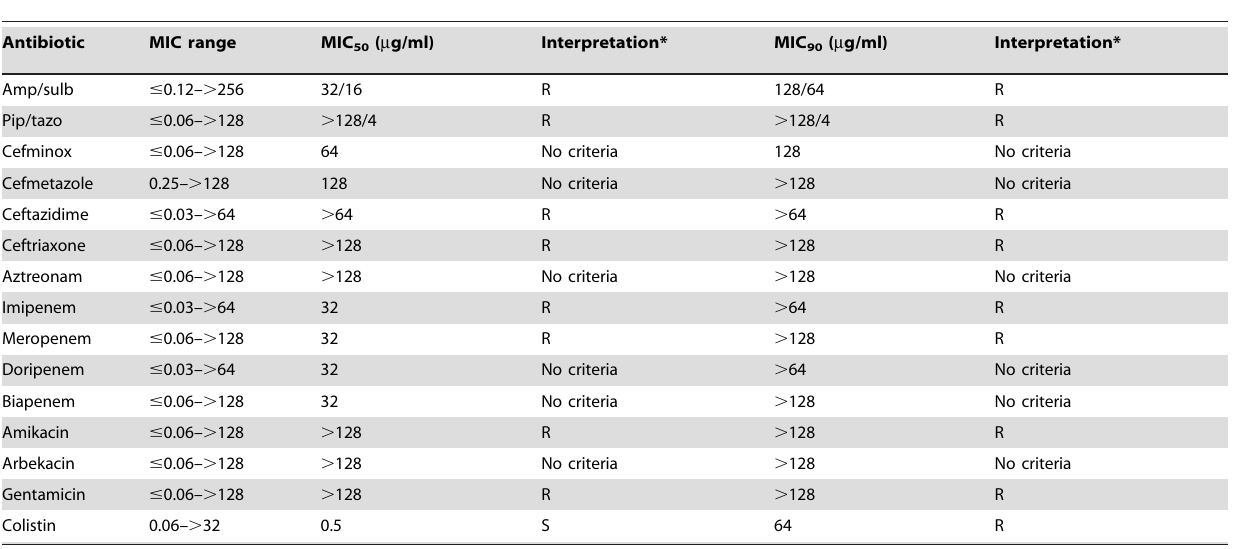
Table 5. Determination and interpretation of the MIC values of the antibiotics tested for Acinetobacter spp.**(n =354).